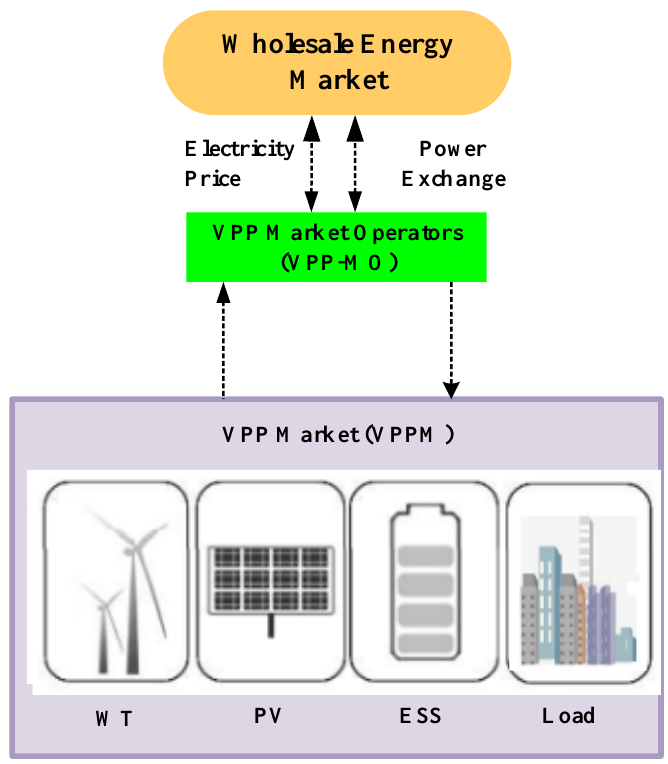
Figure 4. A VPP electricity market structure